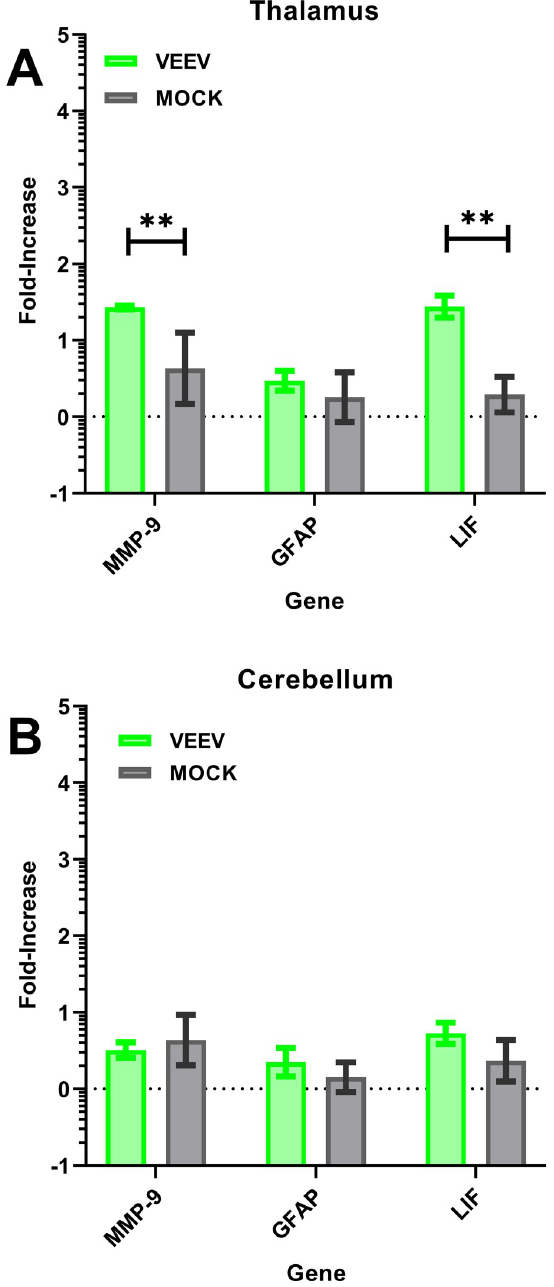
Fig 11. Increase in traumatic brain injury gene expression in VEEV-infected macaque brains. qRT-PCR was used to evaluate expression of mRNA for three genes associated with traumatic brain injury in the brains of VEEV-infected macaques euthanized on day 6. Similar analysis was also done on mRNA from the brains of mock-infected macaques. Two regions of the brain were evaluated, the A) thalamus and B) cerebellum. Fold-change is in comparison to GAPDH expression. Asterisks indicate where statistical analysis indicated a significant difference between VEEV-infected and mock-infected samples; � p � 0.05, �� p � 0.01, ��� p � 0.001.